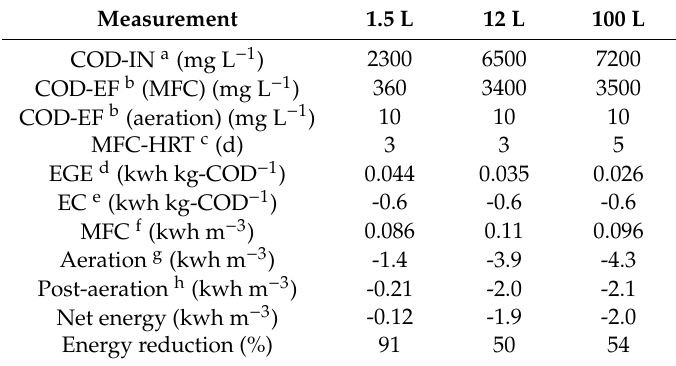
Table 2. Net energy calculation in wastewater treatment combining MFCs with three di ff erent capacities (1.5 L, 12 L, and 100 L) and